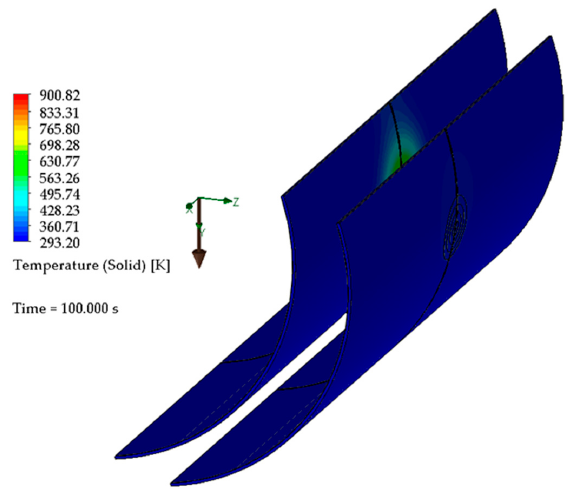
Figure 14. Temperature at 100 s.